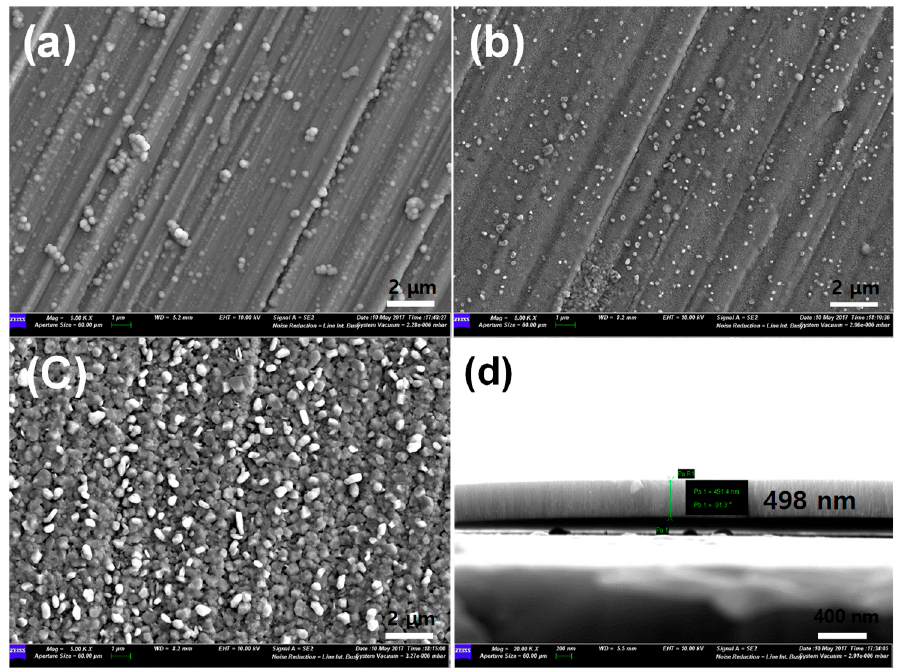
Figure 2. SEM images of NiFe 2 O 4 electrode of ( a ) NFO-600, ( b ) NFO-700, and ( c ) NFO-800 ◦ C. ( d ) Cross-sectional image of NiFe 2 O 4 electrode on the